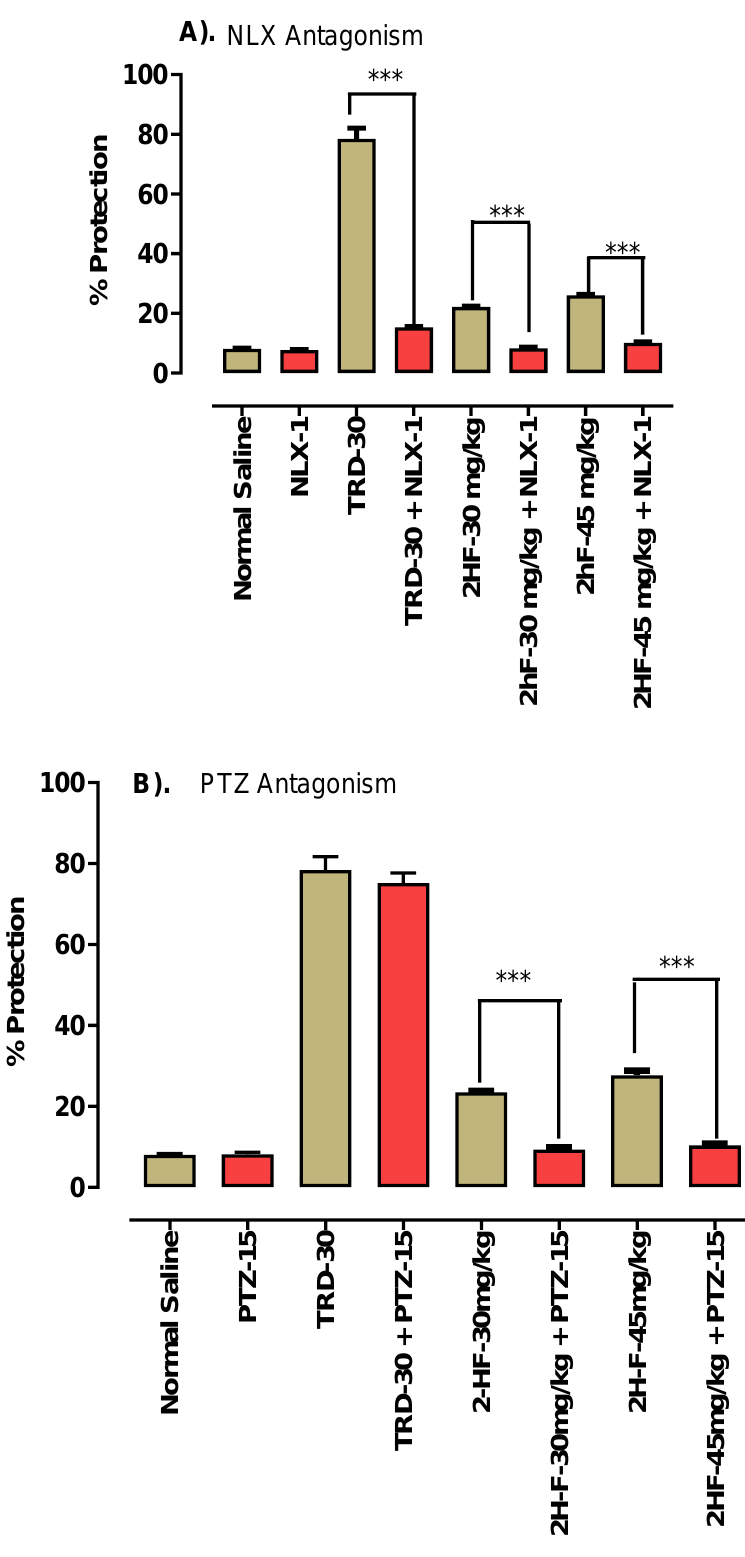
Figure 3. ( A ) Naloxone effect at 1 mg kg − 1 and ( B ) PTZ effect at 15 mg kg − 1 . *** p < 0.001 when compared with control.